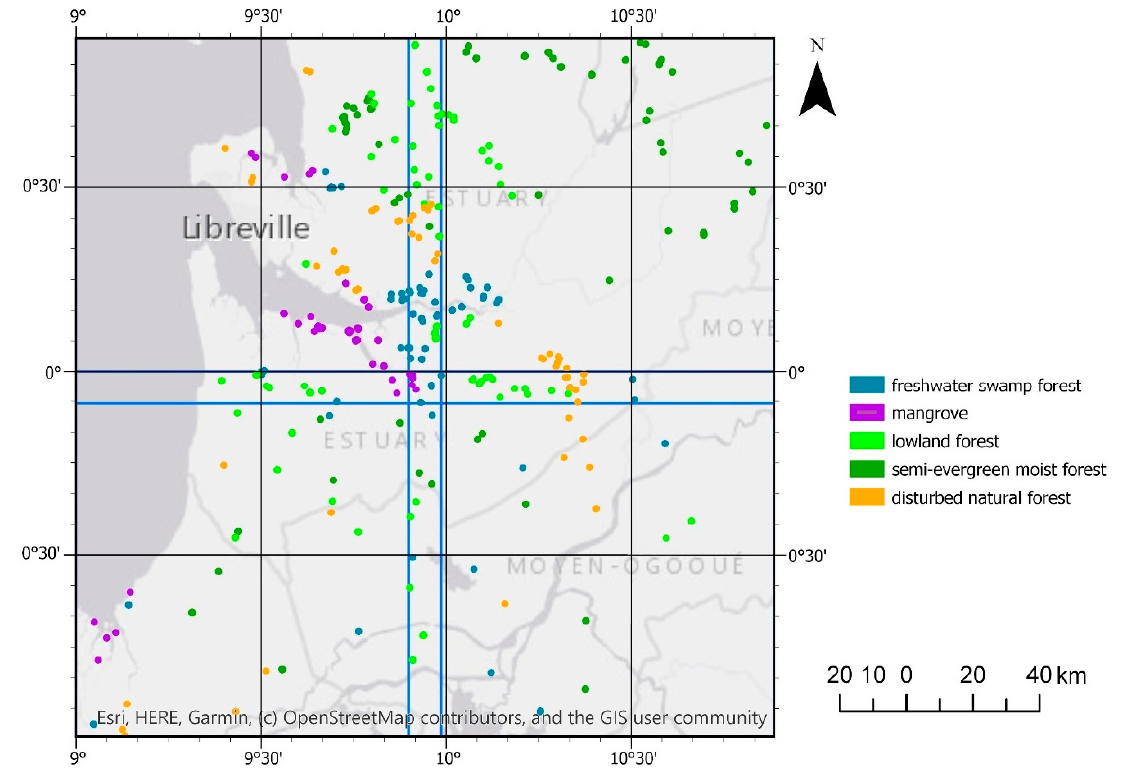
Figure 3. Locations of the reference samples for forest type coloured by the forest type classes; the blue lines indicate the extent of the Sentinel-2 granules.